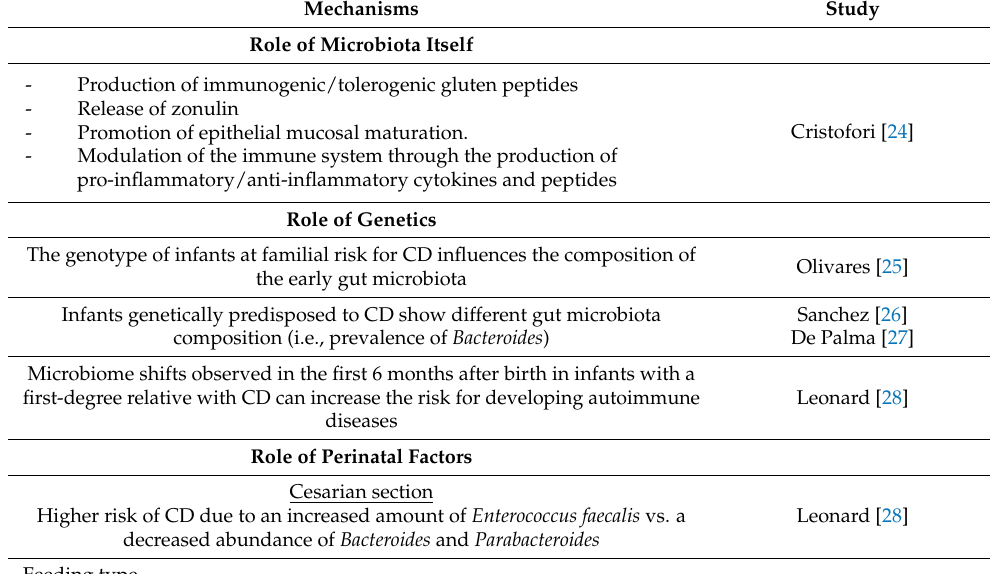
Table 1. Cont. Mechanisms Study Role of Microbiota